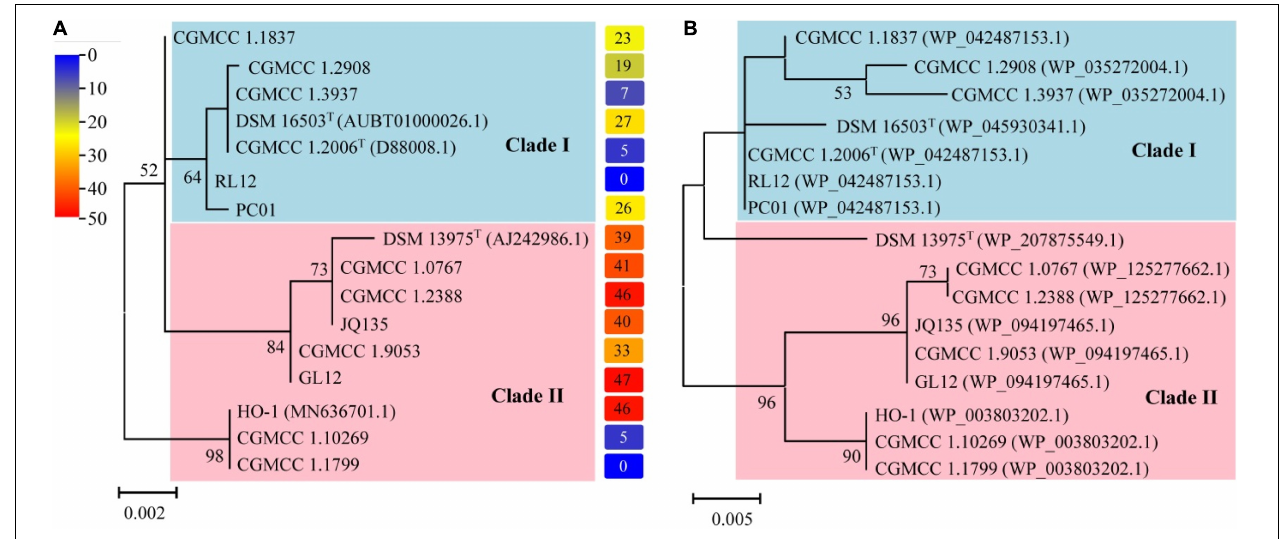
FIGURE 3 | Phylogenetic analyses of the genus Alcaligenes based on 16S rRNA gene sequences (A) and amino acid sequences of DnfAs (B) . The protein accession numbers shown in parentheses represent the best hit of DnfA against NR database (the same in Table 4 ). The columns on the right of (A) represent the heatmap showing the conversion (%) of consumed 15 NH 4 + to 15 N 2 in medium B.